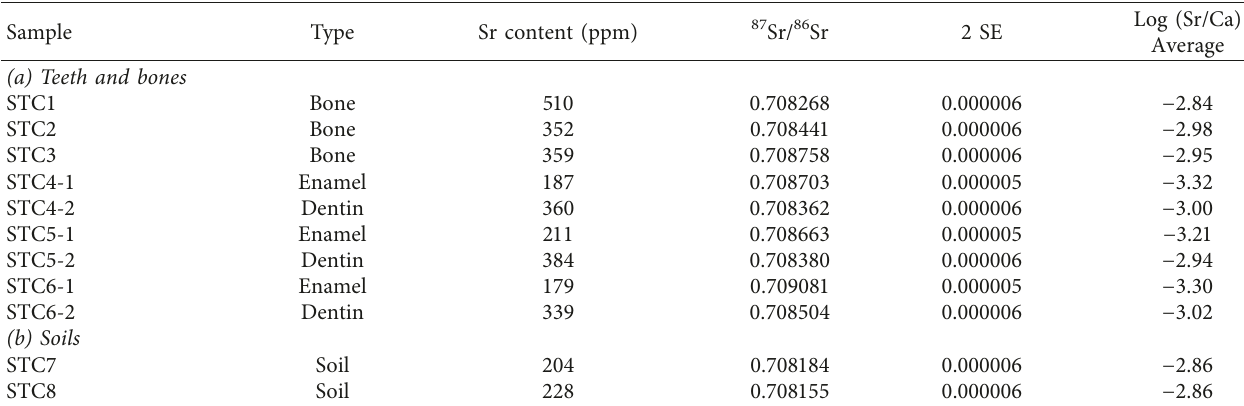
Figure 10: Results of micro-Sr isotopes in teeth and bones of the Ursus spelaeus . (a) Representative image of one tooth sample, sectioned for microdrilling. The thin layer of enamel is well evident with respect to the lighter inner dentin. In yellow are reported the two drilling sites on dentin and enamel; (b) particular back-scattered electron microscopy image of the edge of the tooth showing dentin (dark grey) and enamel (light grey) portion; (c and d) images of two of the analysed bones properly prepared in epoxy resin mounts for microdrilling sampling. In yellow is reported the drilling site; (e) 87 Sr/ 86 Sr versus Sr/Ca (in log scale) diagram showing the results obtained from the analyses of enamel and dentin in the three teeth, compared with bones of the Ursus spelaeus specimen. The 87 Sr/ 86 Sr of soils in which the fossils have been sampled are also reported together with the Sr-isotope field of the Raetavicola Contorta limestone for comparison. (See text for detail) (f) 87 Sr/ 86 Sr versus Sr/Ca (in log scale) diagram comparing the Sr-isotope values of dentin from the three teeth samples with the Sr-isotope range fields of the different geologic formations forming the bedrock outcropping in the area of the Grotta all’Onda cave. Table 4: (a) 87 Sr/ 86 Sr results obtained on microsamples of tooth dentine and enamel and bones of the Ursus spelaeus specimen. (b) 87 Sr/ 86 Sr soils sampled in the Grotta all’Onda cave from which the fossil remains were